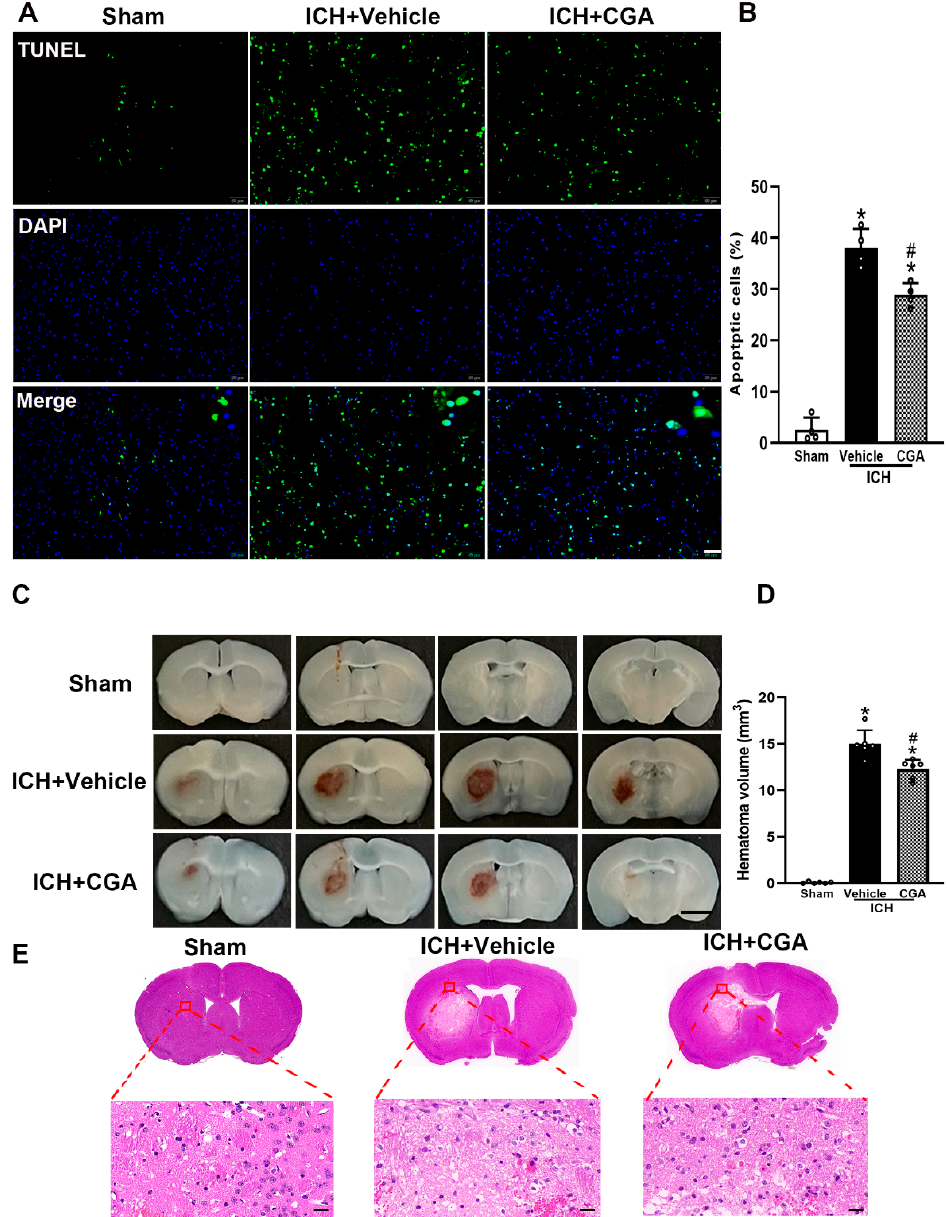
Figure 6. The effects of CGA on cell death and hematoma volume at 3 days after ICH. ( A ) Representative photographs of immunofluorescent staining for TUNEL-positive cells in the perihematomal area. Scale bar = 50 µ m, n = 4 for each group. ( B ) Quantification analysis shows that CGA significantly decreased numbers of TUNEL-positive cells. ( C ) Representative images of ICH brain for hemorrhagic lesion in response to CGA or vehicle treatment. ( D ) Quantification analysis showed that CGA reduced hematoma volume. Scale bar = 2.5 mm. ( E ) Brain injury was evaluated by HE staining. Scale bar = 20 µ m. * p < 0.01 vs. sham; # p < 0.01 vs. ICH + vehicle group. Data are presented as mean ± SD; n = 6 for each